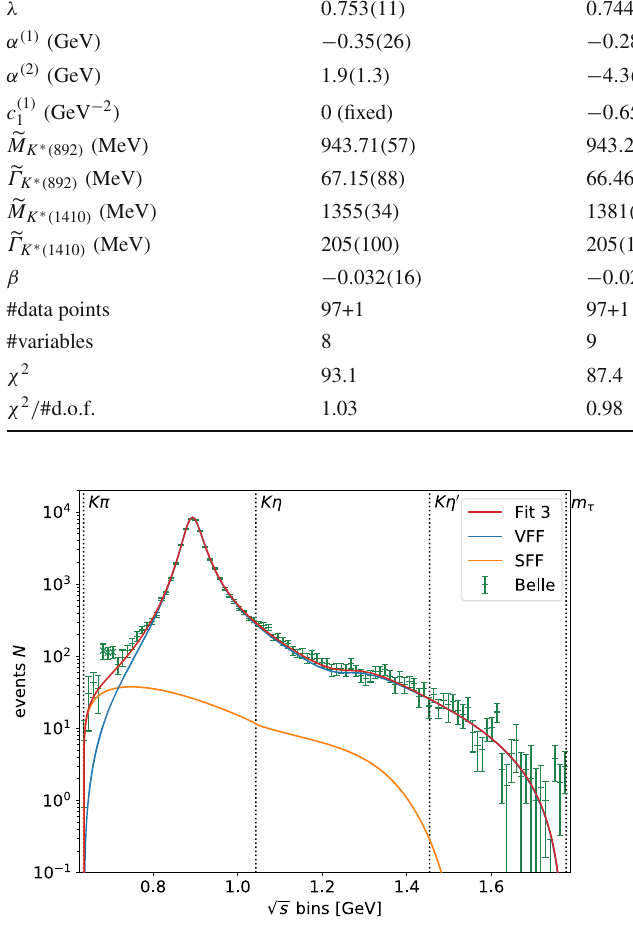
Fig. 5 Comparison of the different fit results presented in Table 3 as well as two BW parameterizations “Belle 1” and “Belle 2” [65] – which ( 700 ) , K ∗ ( 892 ) , and K ∗ ( 1410 ) , or K ∗ ( 700 ) , K ∗ ( 892 ) , include K ∗ 0 0